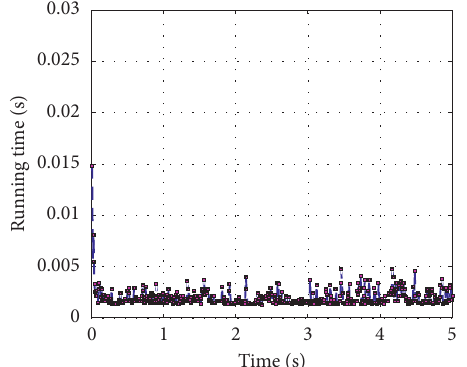
Figure 9: The running time of each step.